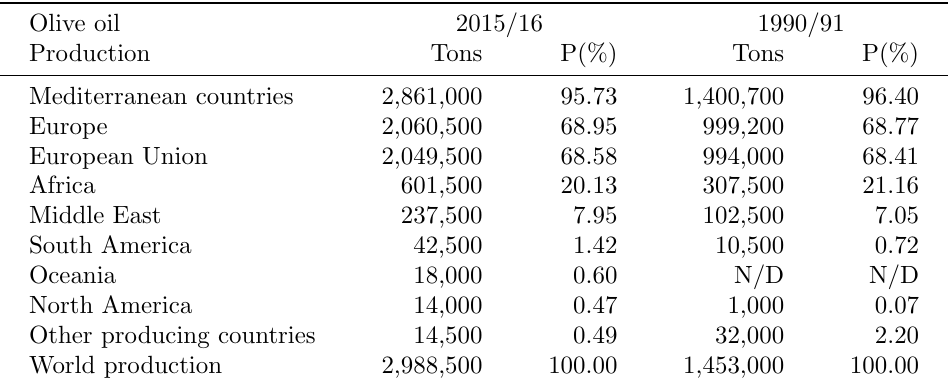
Table 1: Olive oil